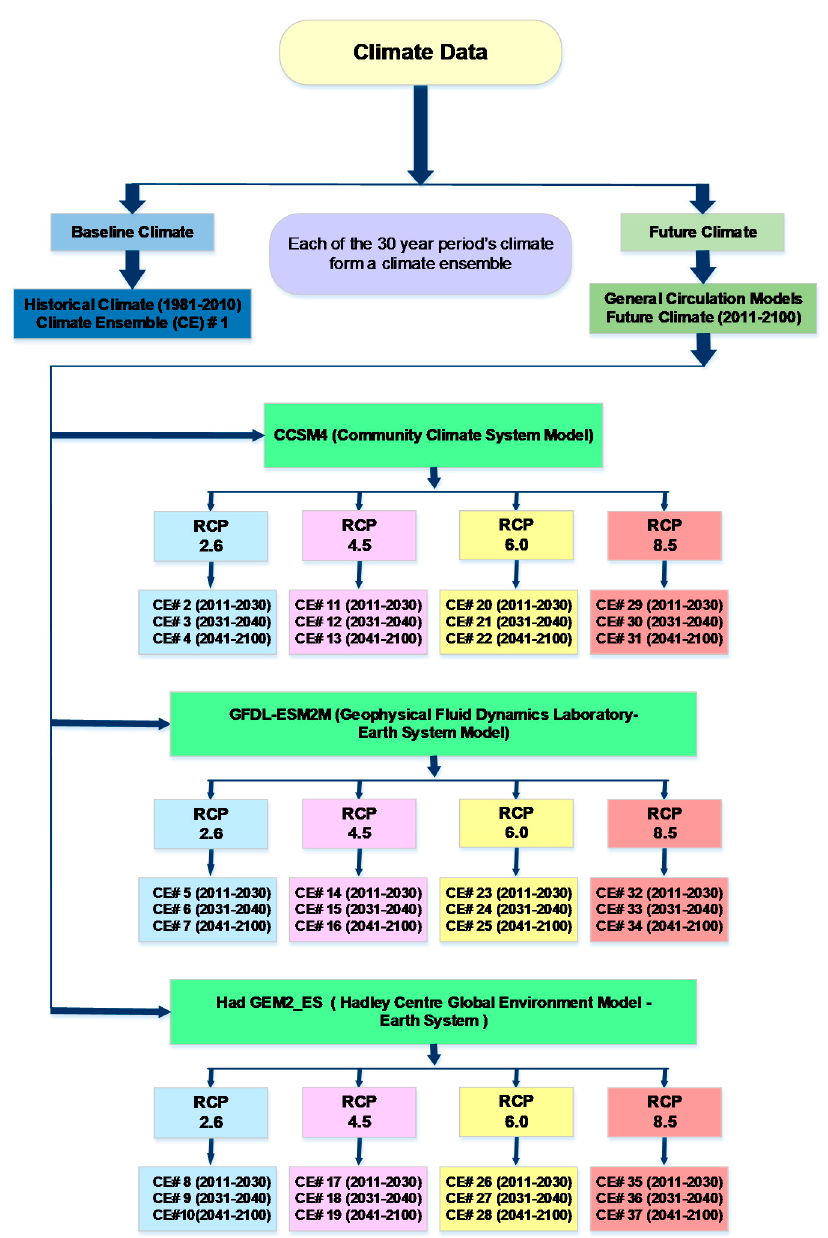
Figure 2. Climate ensembles corresponding to different global circulation models (GCMs) and representative concentration pathways (RCPs).